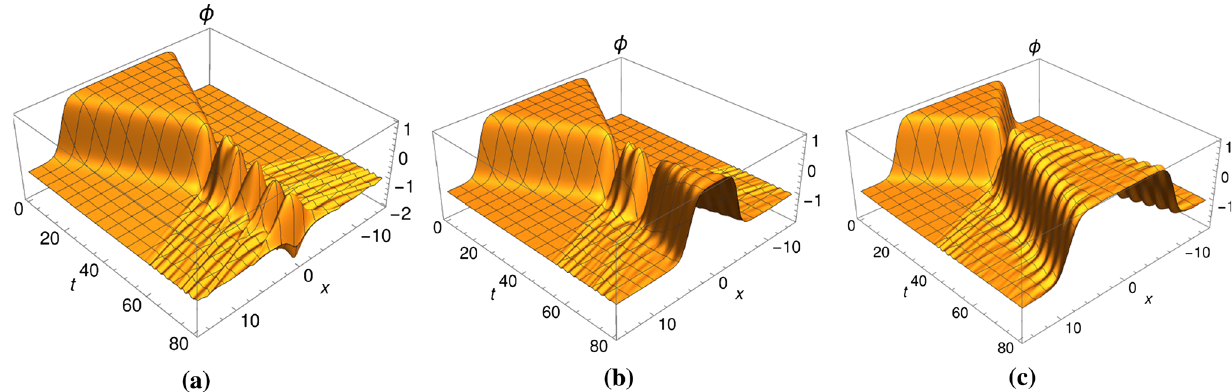
Fig. 6 Evolution of the scalar field φ( x , t ) during the collision of a kink and an antikink. Parameters are (cid:9) = 0, γ = 2 . 667 and a v in = 0 . 200, b v = 0 . 228 and (c) v = 0 . 340. In a the kink and the antikink annihilate, in b they bounce two times before separating and in c they in in